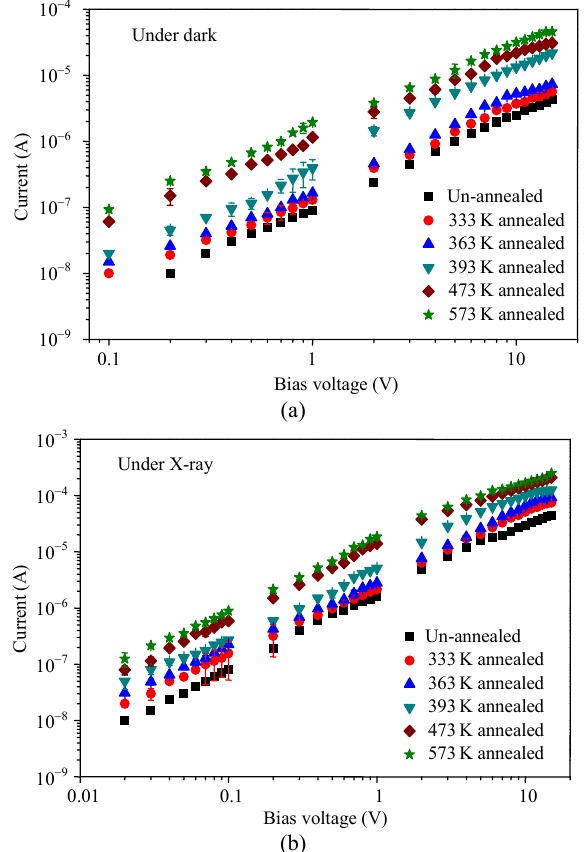
Fig. 4 I-V characteristics of an un-annealed and 333 K, 363 K, 393 K, 473 K, and 573 K annealed films recorded under the (a) dark condition and (b) X-ray radiation condition.